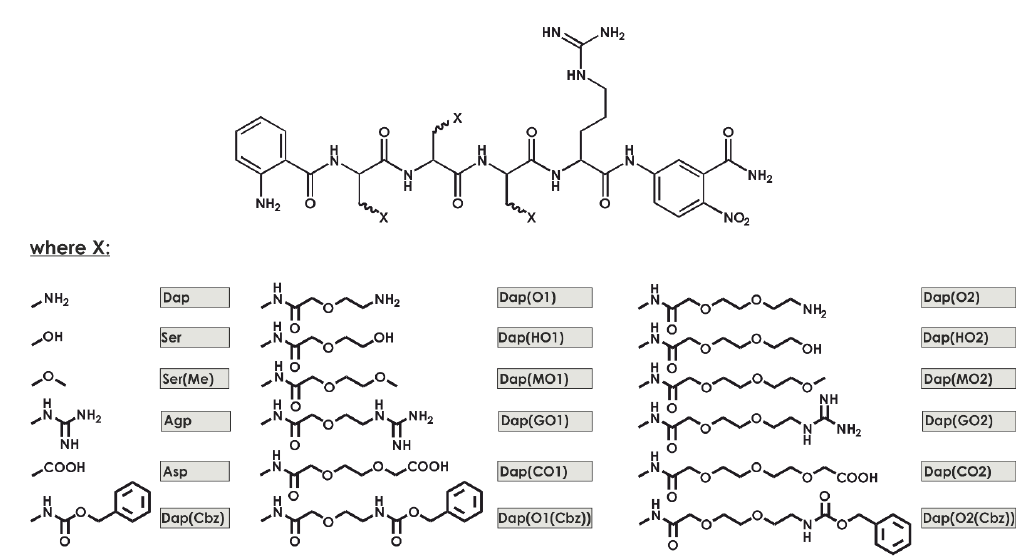
Figure 1. General formula for the library and its components. L-2,3-diaminopropionic acid (Dap), Ser, Ser(Me), L-2-amino-3-guanidino-propionic acid (Agp), Asp, Dap(Cbz), 5-(t-butyloxycarbonyl- amino)-3-oxapentanoic acid (abbreviated as O1), 2-(2-tert-butoxyethoxy) acetic acid (HO1), 5- methoxy-3-oxapentanoic acid (MO1), 5-[N-t-butyloxycarbonyl-N’-(2,2,4,6,7-pentamethyldihydro